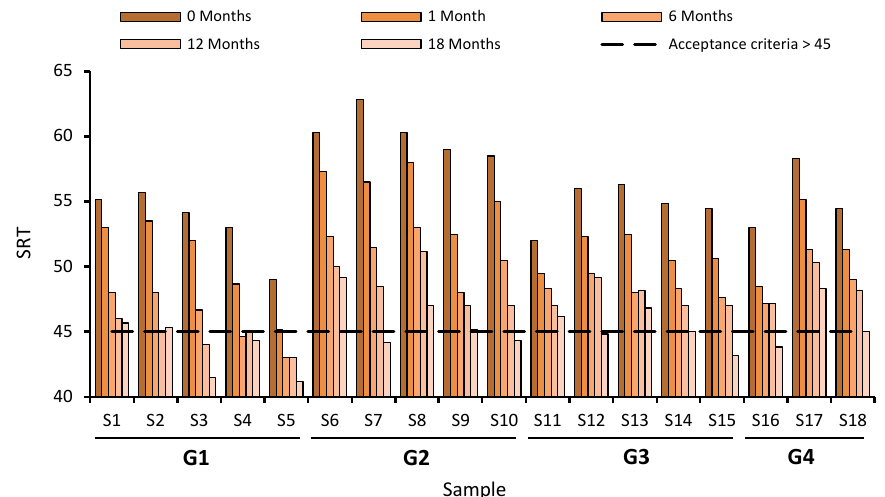
Figure 15. Skid resistance coefficient (SRT) evolution on test samples during the first 18 months of service.